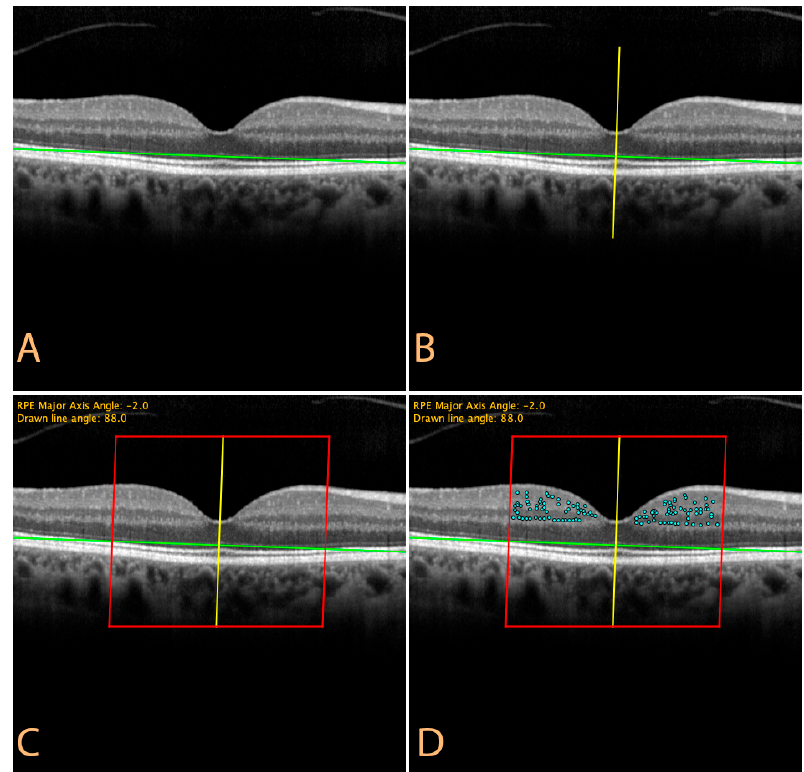
Figure 1. OCT image processing by ImageJ script (available as supplementary material); ( A ) Identification of the retinal pigment epithelium major axis; ( B ) A line passing through the center of the fovea is drawn (reference line), according to the angle suggested by the script: ( C ) Two lines are automatically superimposed, 1500 μ m apart of the reference line, temporally and nasally, defining a region of interest (ROI); ( D ) Hyper-reflective retinal spots are counted by the investigator inside the newly defined ROI.